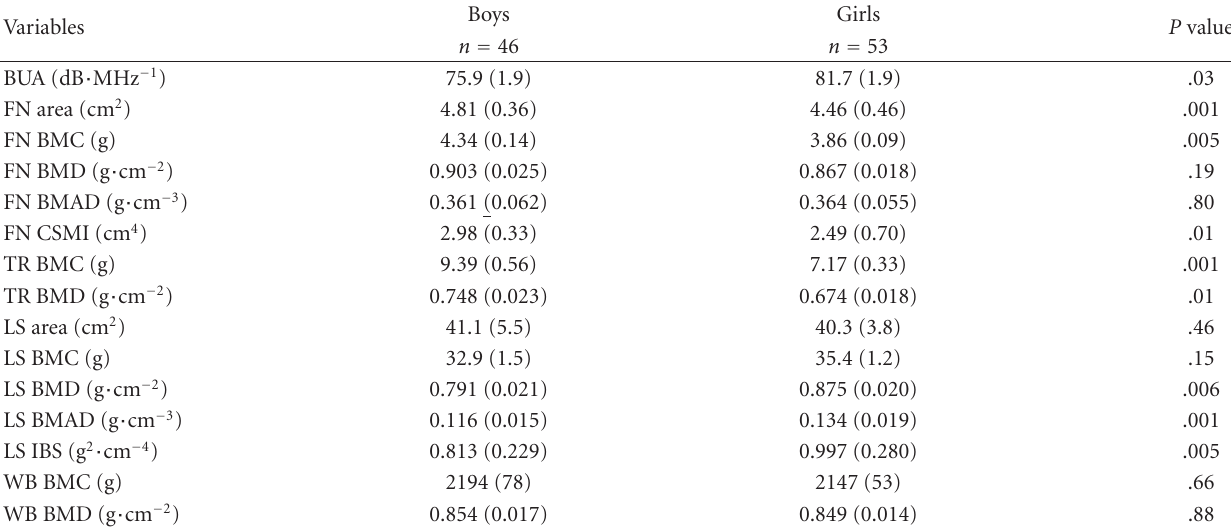
Table 2: Bone parameters for adolescent boys and girls ( n = 99). Mean (SD).